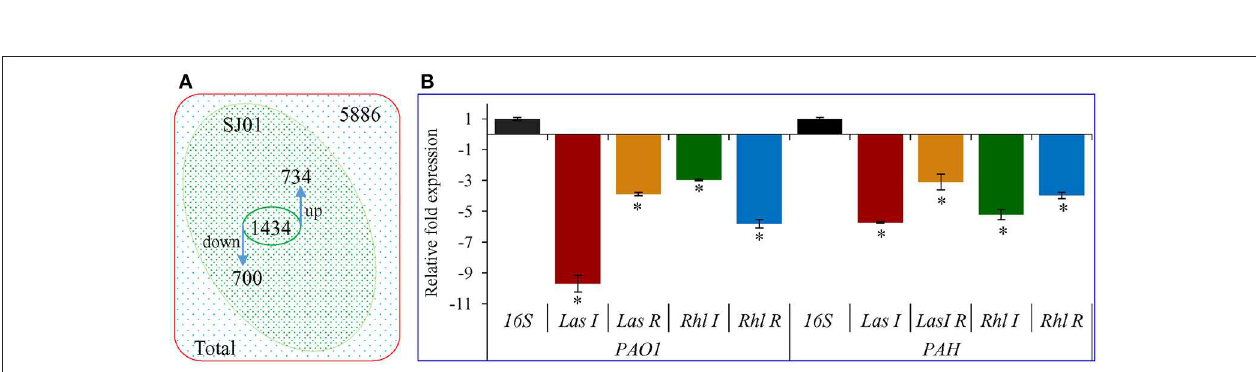
FIGURE 9 | Analysis of active fraction showing quorum sensing inhibition. (A) GC chromatograms and (B) ESI-MS/MS of the C18-100 active fraction of D. tsuruhatensis SJ01 extract and structure of 1,2-benzenedicarboxylic acid, diisooctyl ester (redrawn by ChemBioDraw Ultra 12.0).